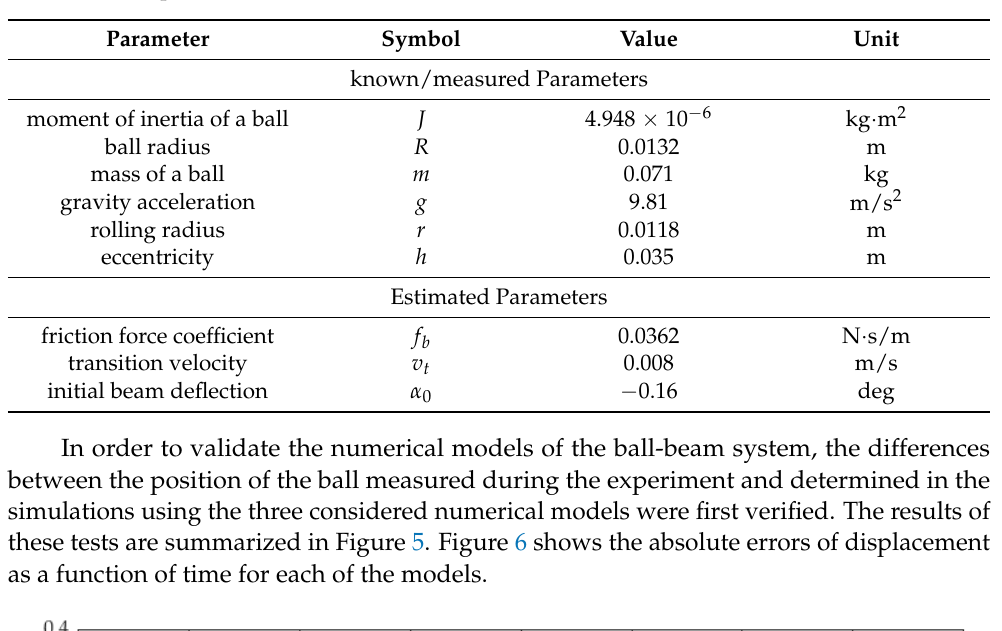
Table 1. List of parameters used in numerical calculations.